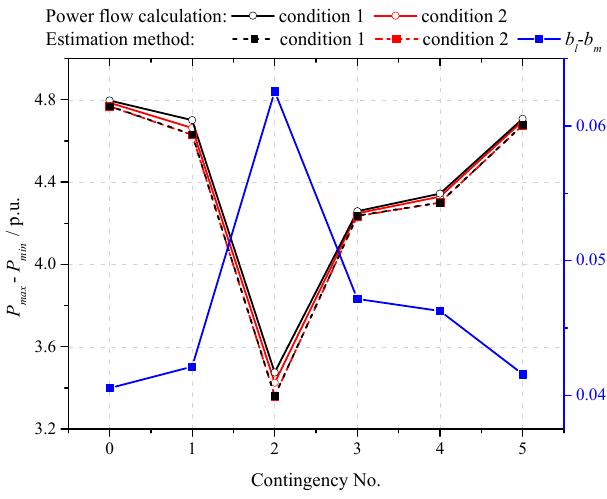
ff erent operating conditions and